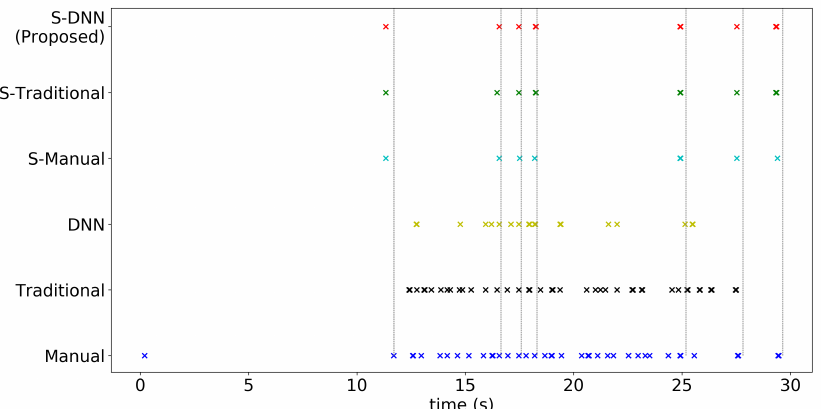
Figure 10. Predicted WBC event counts and ground truths for capillary 4. The x -axis denotes time stamp in the video, and the y -axis represents the different combinations of the video stabilization process and capillary segmentation methods. The gray vertical dashed lines indicate the events identified by experts. Note that all the segmentation methods with the stabilization preprocessing correctly recognize the counts of WBCs.